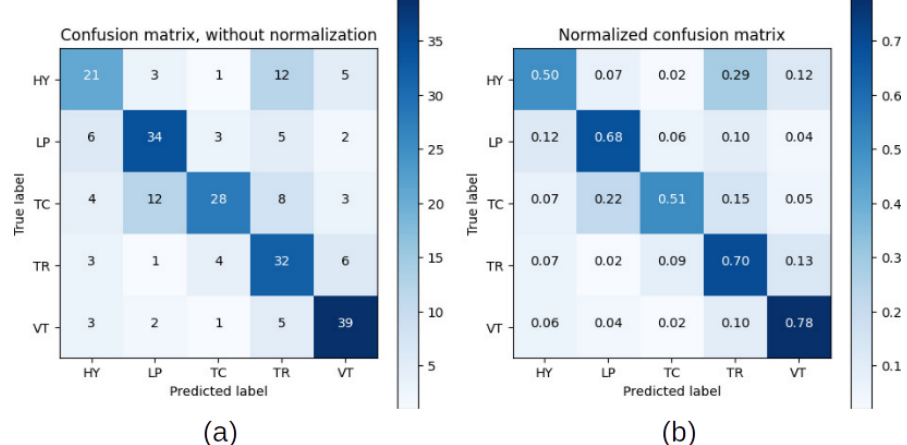
Figure 11. Confusion matrices without normalization (a) and normalized (b) , for experiment (v).